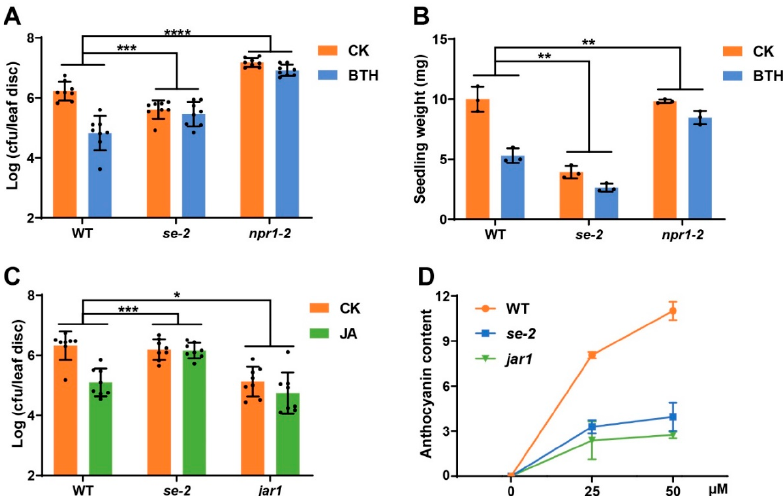
Figure 6. The phenotypes of SA and JA induced responses in the se mutant. ( A ) BTH induced resistance to Psm ES4326 in WT, se, and npr1 mutants. Data are shown as mean ± SD ( n = 8). ( B ) BTH induced growth inhibition assay in WT, se, and npr1 mutants. Data are shown as mean ± SD ( n = 3). ( C ) JA induced resistance to Psm ES4326 in WT, se, and jar1 mutants. Data are shown as mean ± SD ( n = 8). ( D ) JA induced anthocyanin accumulation assay in WT, se, and jar1 mutants. Data are shown as mean ± SD ( n = 3). All these experiments were conducted as previously described and repeated three times with similar results. Significant difference was detected by two-way ANOVA. * p < 0.05; ** p < 0.01; *** p < 0.001; **** p < 0.0001.